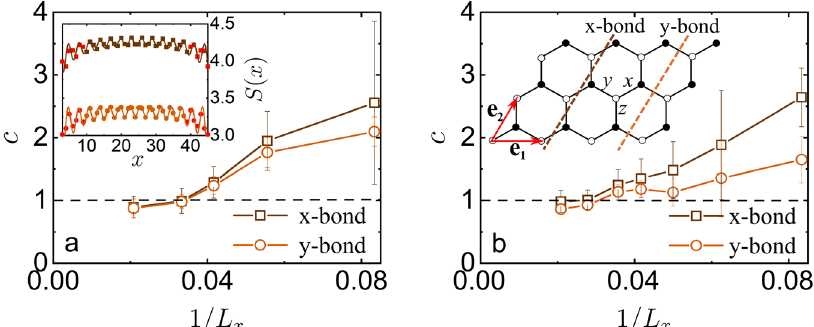
Fig. 5 Central charge. The extracted central charge c as a function of L x using Eq. (3) for three-leg cylinder at doping level a δ = 1/9 and b δ = 1/12. Error bars denote numerical uncertainty. Inset in a is the entanglement entropy S ( x ) on three-leg cylinder of length L x = 48, a few data points in red are removed to minimize the boundary effect. Inset in b shows the smooth boundaries parallel to the e 2 direction through x and y -bond labeled by the dashed